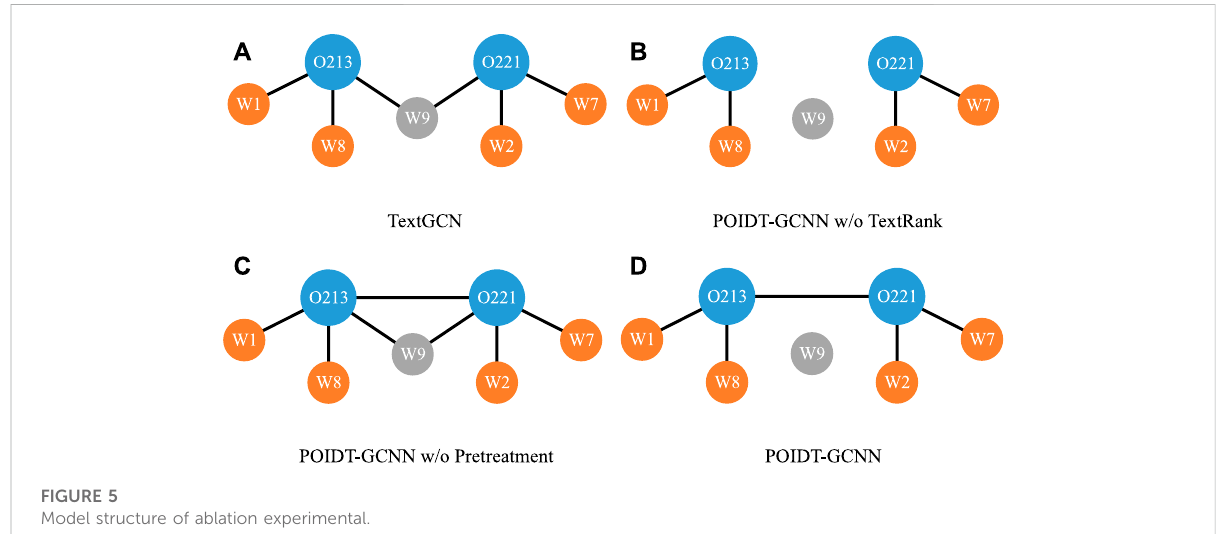
FIGURE 5 Model structure of ablation experimental.